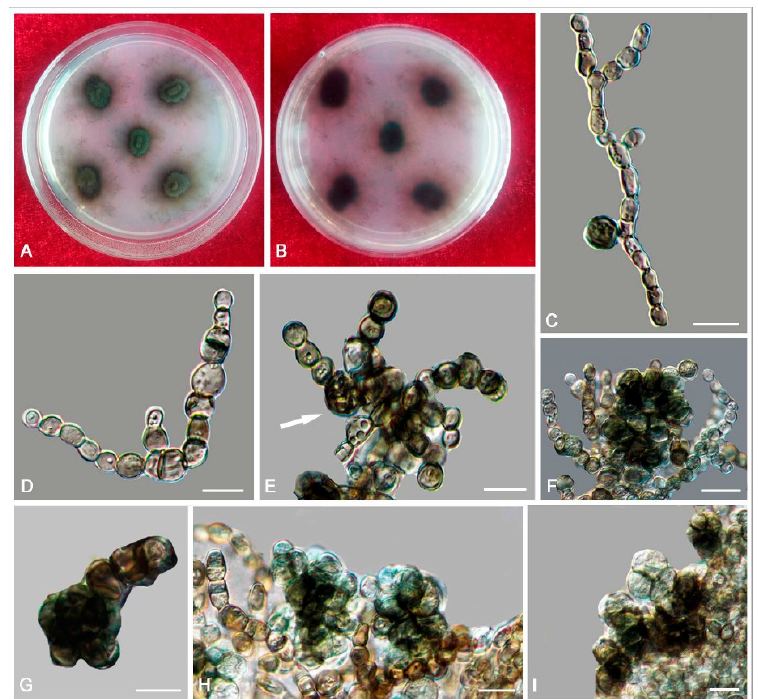
Figure 12. Lithohypha catenulata (CGMCC 3.14885). ( A , B ) Colony surface and reverse after 20 weeks on MEA. ( C , D ) Catenated, moniliform hyphal cells proliferating often at the apex. ( E ) Swollen cells with dark brown fragmented crusts on their surface (arrows). ( F – I ) Solitary, enlarged, dark pigmented multicellular bodies with transverse and longitudinal septa. Scale bars: ( C – I ) = 10 μ m.